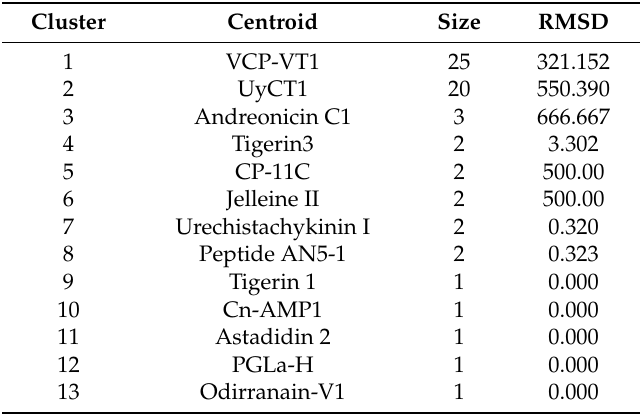
Table 5. Clusters obtained from hierarchical clustering with threshold set at